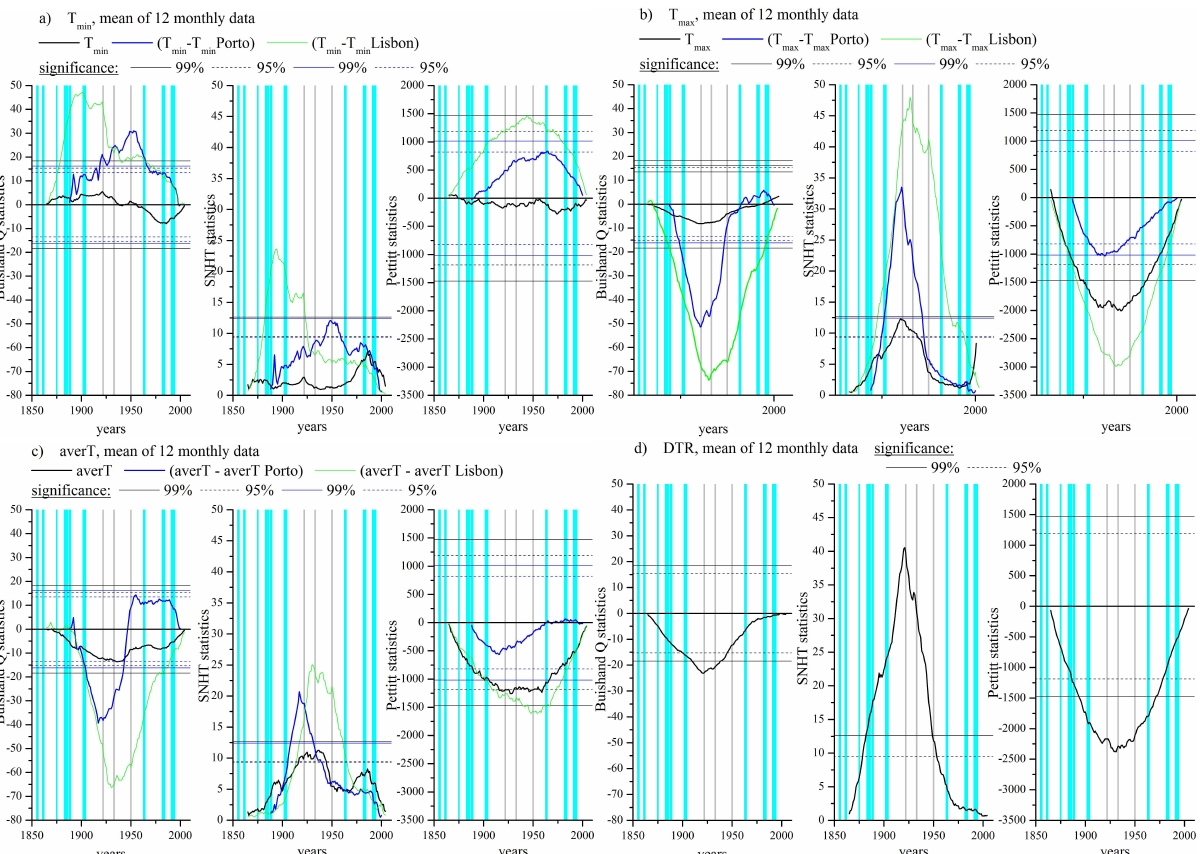
Figure 21. Coimbra: average of 12 monthly series of Buishand Q test (left panels), SNHT (middle panels) and Pettitt tests (right panels) statistics of T min (a) , T max (b) , T aver (c) and DTR (d) . Statistics of temperature series are shown in black, statistics of di ff erences between Coimbra and Porto are shown in blue and between Coimbra and Lisbon are shown in green. Solid and dashed horizontal lines show probability levels of 99% and 95%, respectively. Grey vertical lines show known dates of instrumental changes, cyan broad vertical lines show periods of strong volcanic